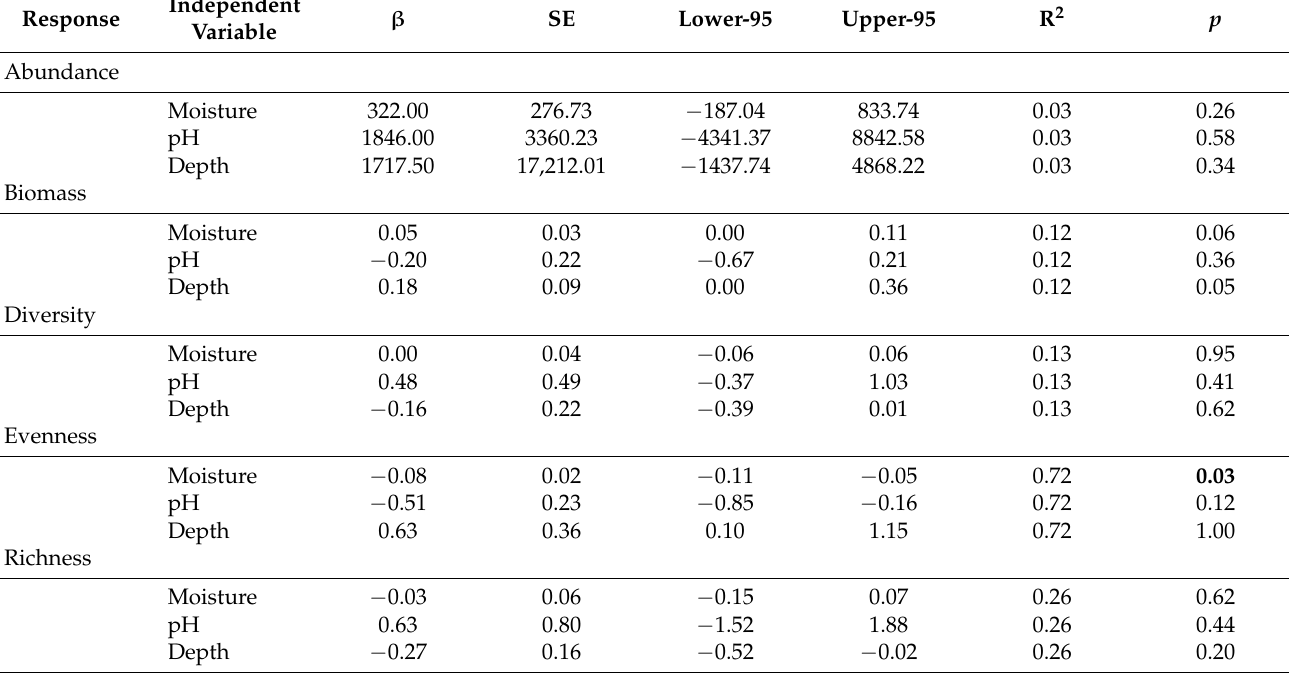
Table 3. Results of regression analyses between effect size (dependent variable = Hedges’ g) and three independent variables (log-transformed) extracted from the literature (moisture in %, pH, Depth in cm). Significant differences are highlighted in